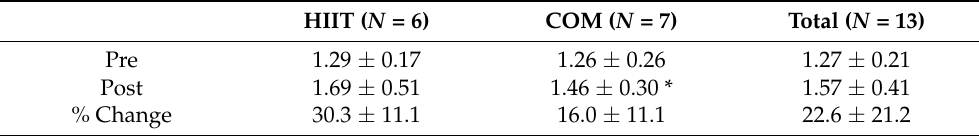
Table 3. Capillary-to-fibre ratio prior (Pre) and after (Post) high-intensity-interval training (HIIT) or combined HIIT with strength training (COM) program, and in the total number of patients. Values are presented as mean ± SD, and percentage change (%Change) from baseline. * Significantly different compared to Pre values ( p <